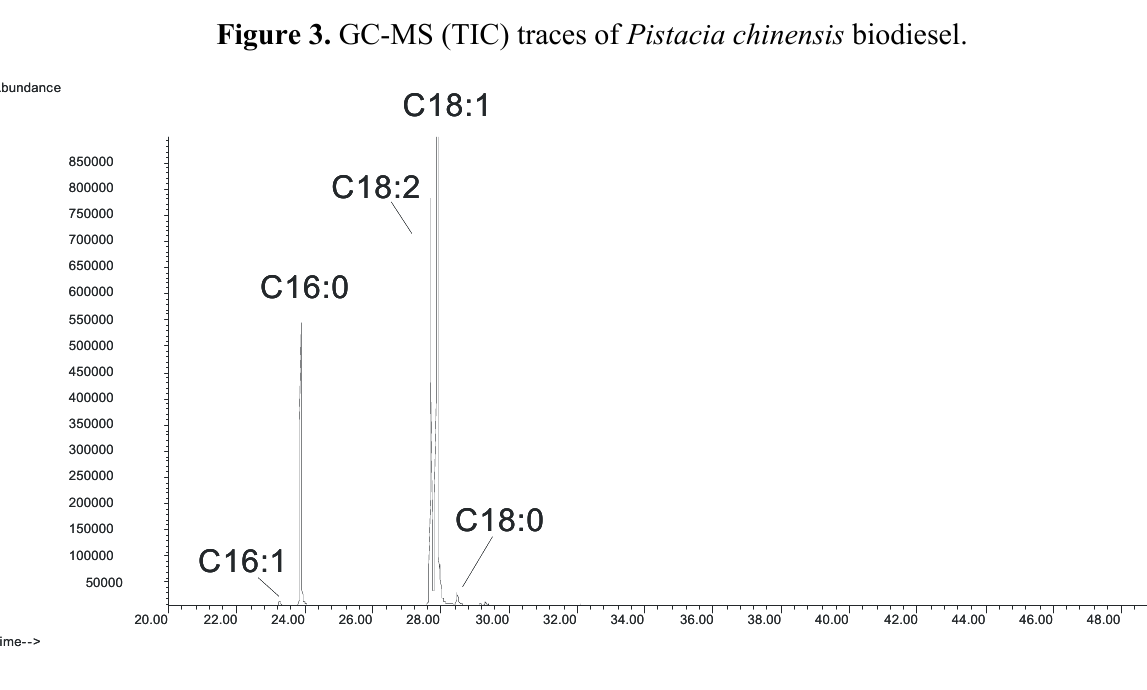
Table 4. Composition (%) of biodiesel of Pistacia Chinensis